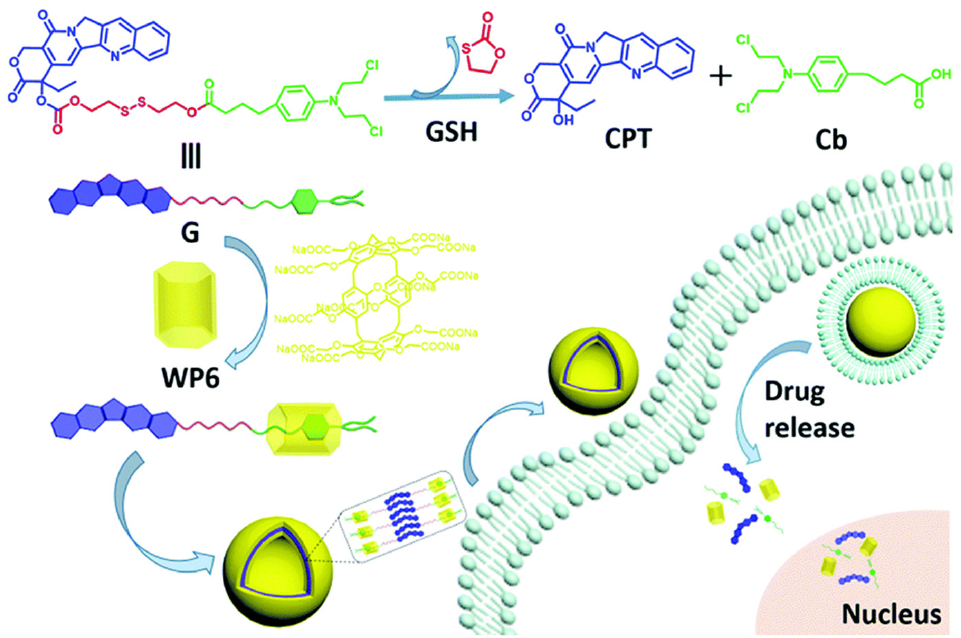
Figure 10. A supramolecular vesicle determined by water-soluble pillararene [6] (WP6) and drug precursors (reproduced with permission of Royal Society of Chemistry from ref. [77]).